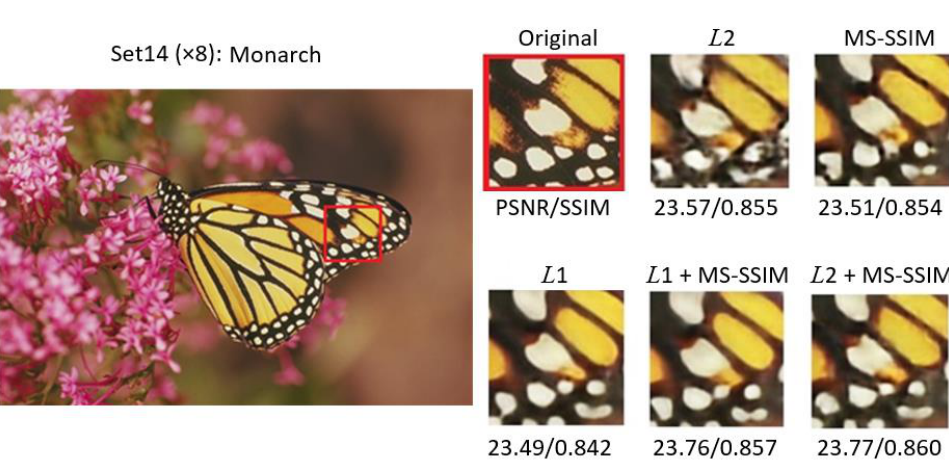
Figure 9. Visual comparison of different objective functions on the “Monarch” image from the Set14 dataset at × 8